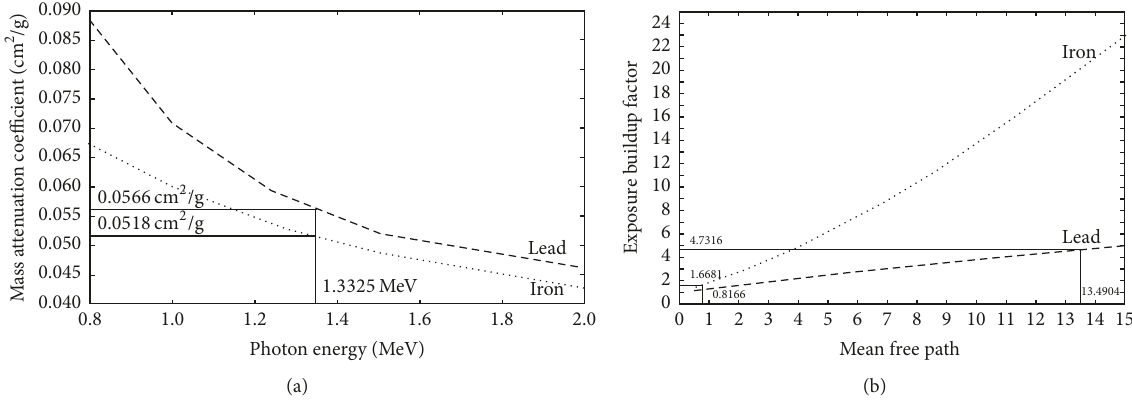
Figure 8: Summary of MATLAB calculation for (a) mass attenuation coefficient (𝜇/𝜌) and (b) exposure buildup factor (𝐵) .